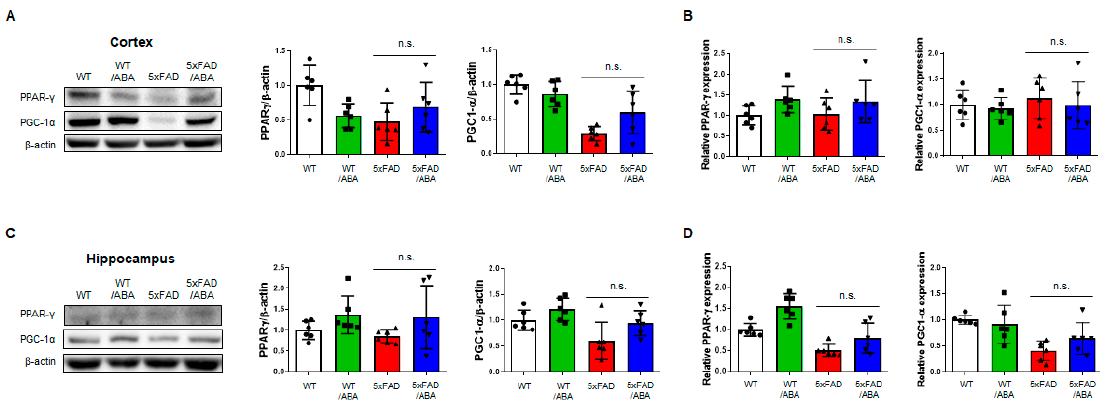
Figure 5. ABA does not activate the peroxisome proliferator-activated receptor gamma (PPAR- γ ) pathway. ( A ) The protein levels of PPAR- γ and peroxisome proliferator-activated receptor gamma coactivator 1-alpha (PGC-1 α ) in the cortex. ( B ) The mRNA expressions of PPAR- γ and PGC-1 α in the cortex. ( C ) The protein levels of PPAR- γ and PGC-1 α in the hippocampus. ( D ) The mRNA expressions of PPAR- γ and PGC-1 α in the hippocampus. All data are expressed as the mean ± S.E.M. ( n = 6). Statistics were analyzed by one-way ANOVA with Tukey’s post hoc test; n.s., non-significant.